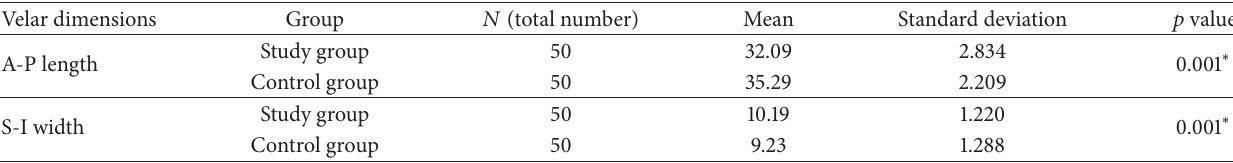
Table 2: Mean distribution of anteroposterior (A-P) length and superoinferior (S-I) width in the study group and control group using Mann- Whitney 𝑈 test.